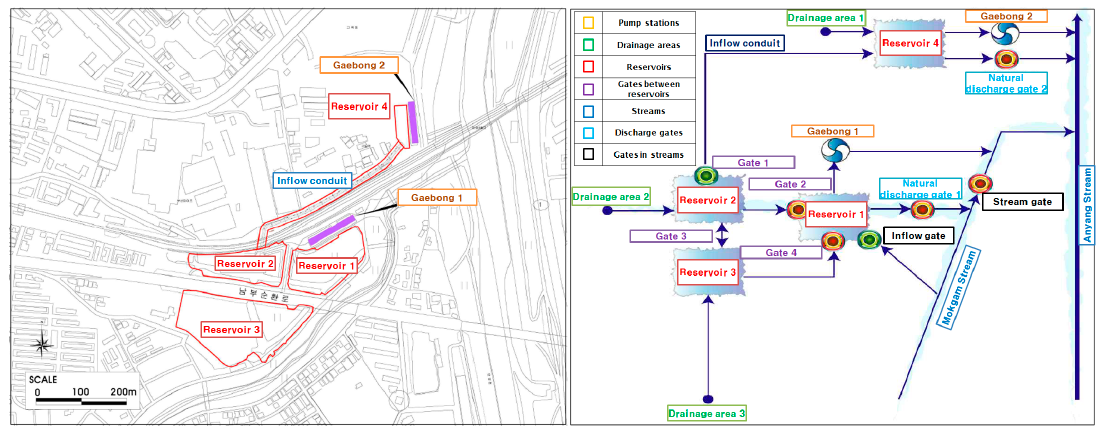
Figure 8. Drainage facilities of the target watershed.